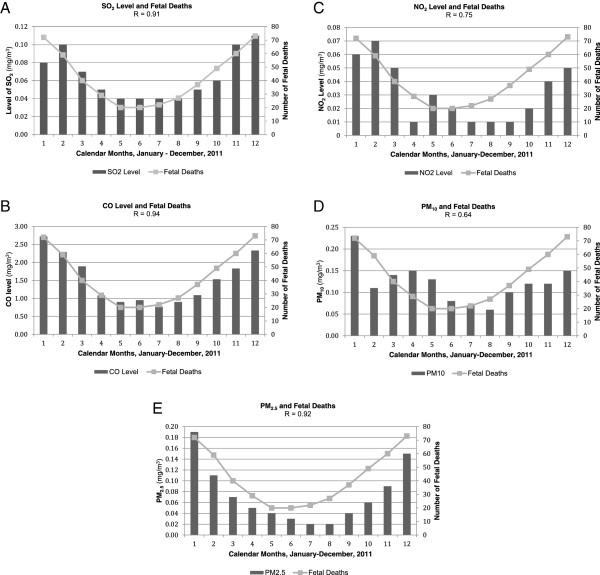
Calendar monthly averages of ambient air pollutant levels correlated with fetal death. (A) SO2.(B) CO. (C) NO2.(D) PM10.(E) PM2.5. Monthly average air pollutant levels are shown as black bars; monthly number of fetal deaths at the National Center for Maternal and Child Health in Ulaanbaatar, Mongolia in 2011 shown as grey dots and a connecting line.